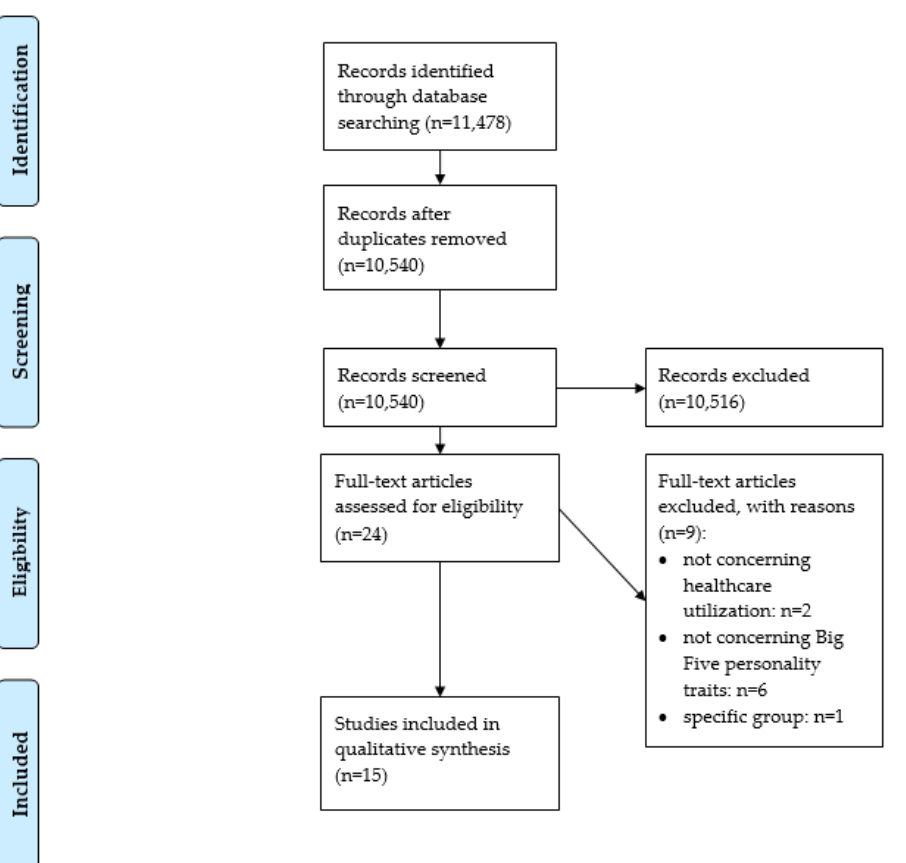
Figure 1. Preferred reporting items for systematic review and meta-analysis (PRISMA) flow diagram